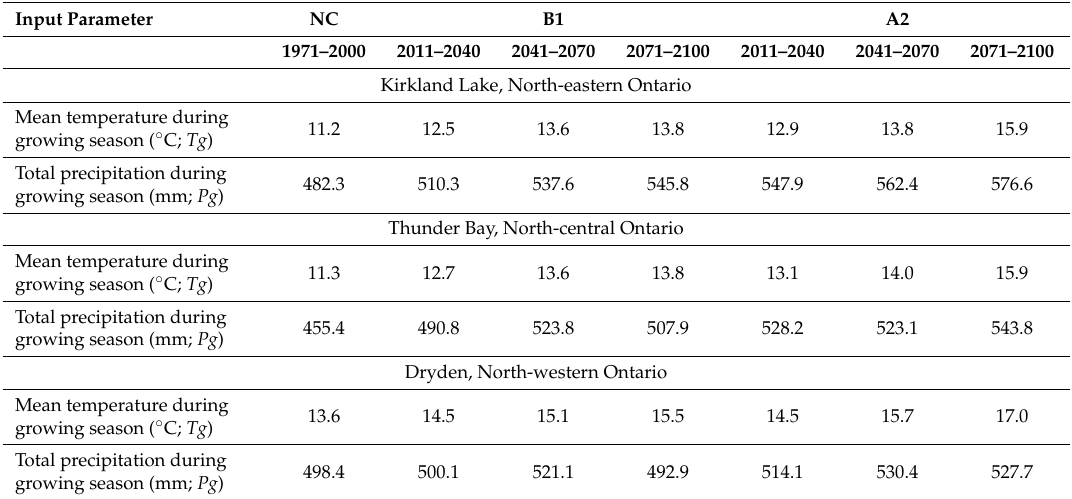
Table 1. Climatic input parameters for the modified structural stand density management models: seasonal temperature and moisture values specific to the NC, B1, and A2 emission scenarios by commitment period at each